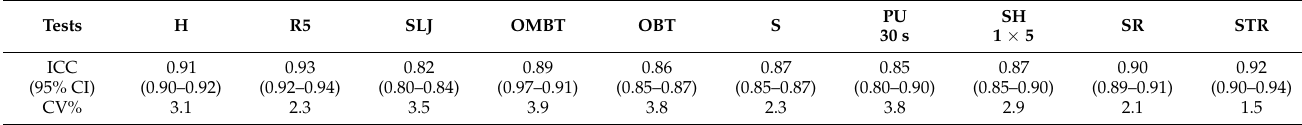
Table 3. Reliability values of selected field test for elite junior tennis players.